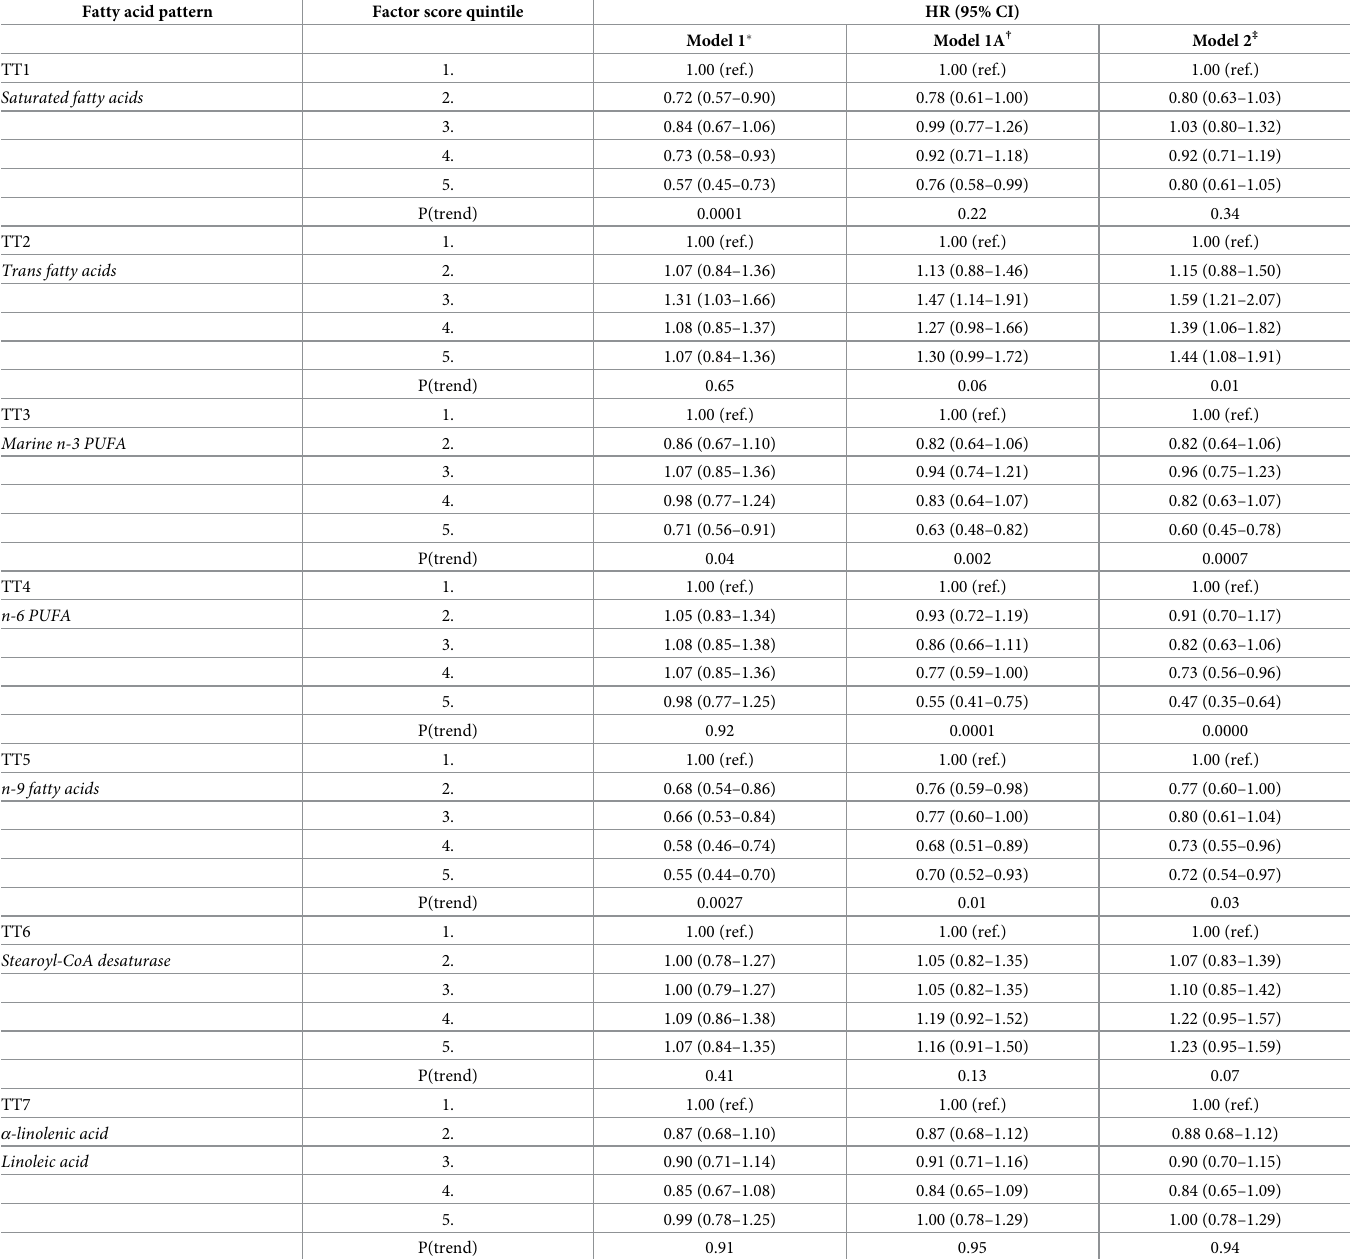
Table 4. Results for